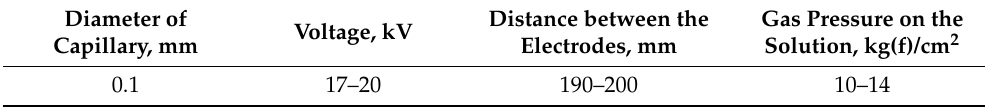
Table 1. Conditions of the ES method.